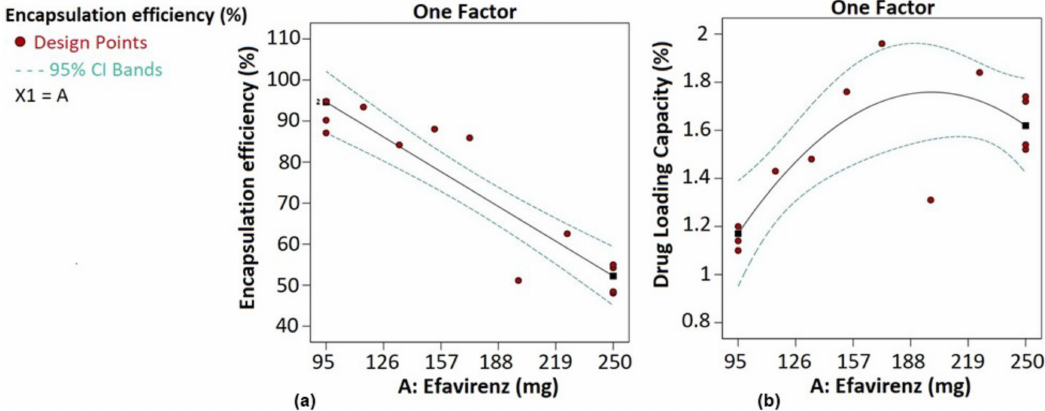
Figure 5. Encapsulation efficiency ( a ) and drug loading capacity ( b ) profiles.